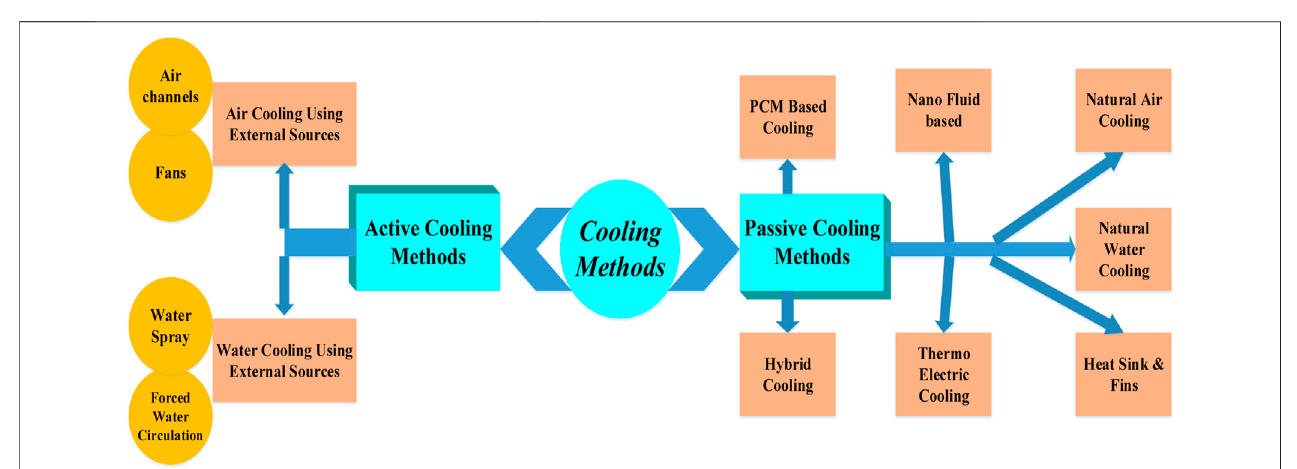
FIGURE 3 | Various solar tracking